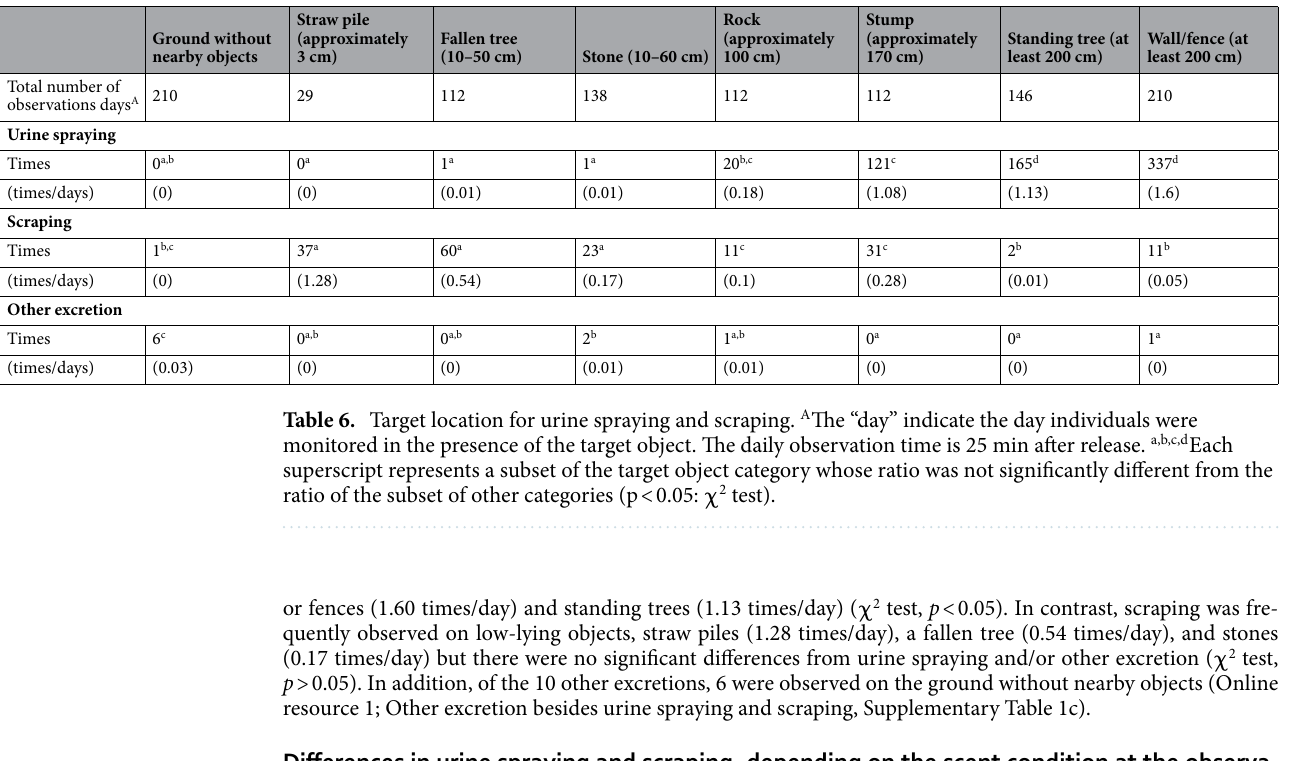
Ground without nearby